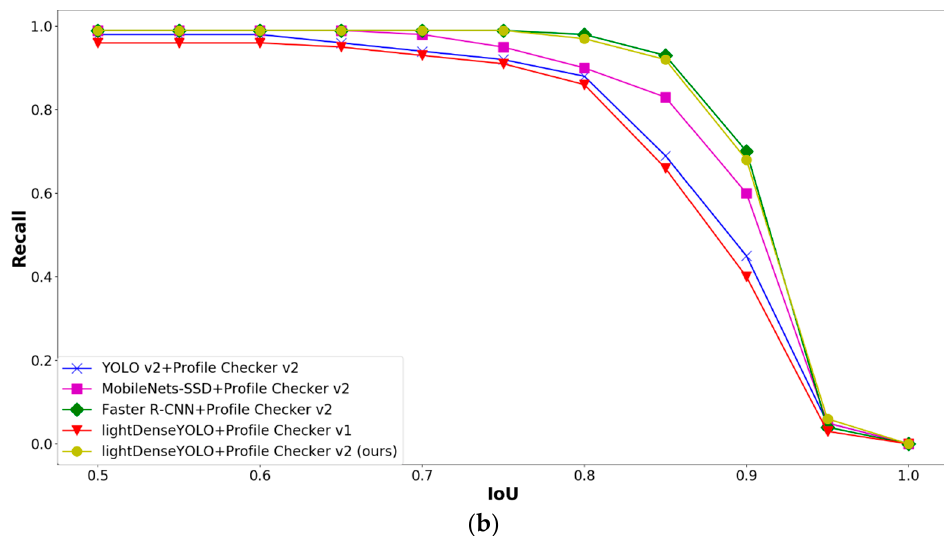
Figure 14. Comparative graphs of ( a ) precision and ( b ) recall by different CNN marker detectors with Profile Checker algorithms according to IoU thresholds.